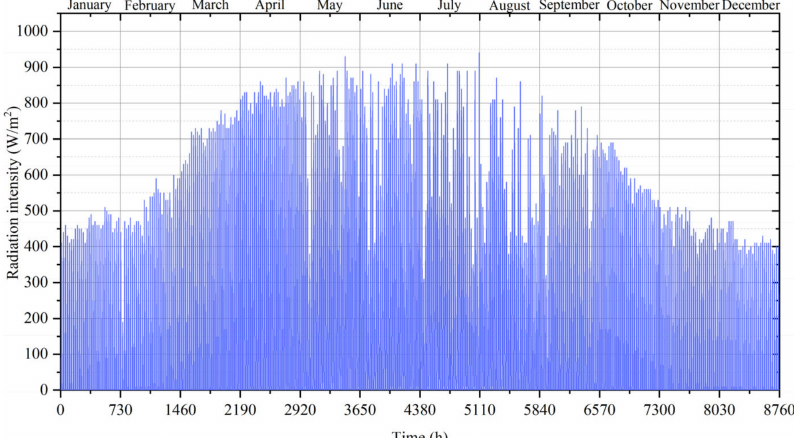
Figure 4. Hourly radiation intensity in Tianjin,